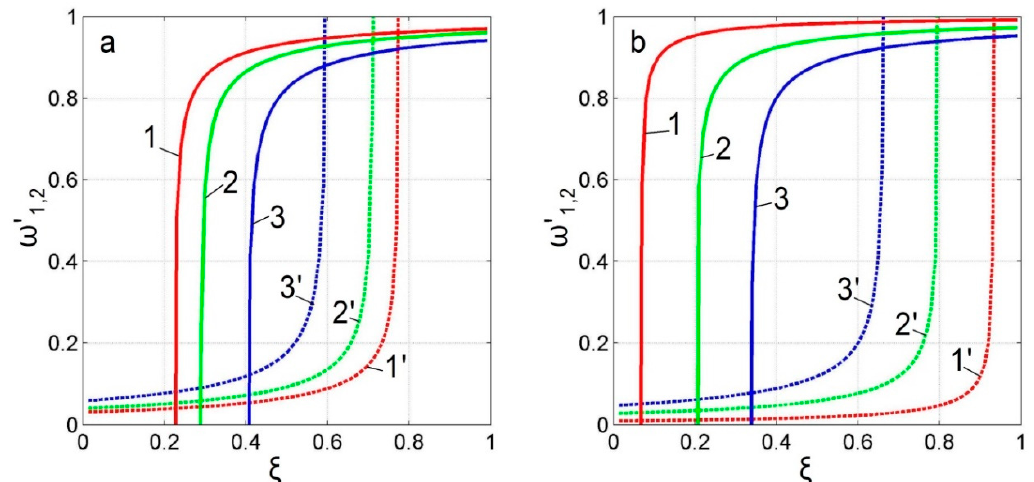
Figure 3. Dependence of the normalized angular velocities of the two parts of a sample (blocks 1 and 2), ω ′ (1, 2, 3) and ω ′ (1 ′ , 2 ′ , 3 ′ ) on the position of the sample in the HPTE container channel, ξ , for ( a ) different values of the coefficient of friction ( m = 0.9 (1 and 1 ′ ); m = 0.7 (2 and 2 ′ ); m = 0.5 (3 and 3 ′ )) in the absence of holding elements and ( b ) different lengths of the holding elements ( H ’ = 0.9 (1 and 1 ′ ); H ’ = 0.7 (2 and 2 ′ ); H ’ = 0.5 (3 and 3 ′ )) for a fixed magnitude of the coefficient of friction ( m = 0.3).